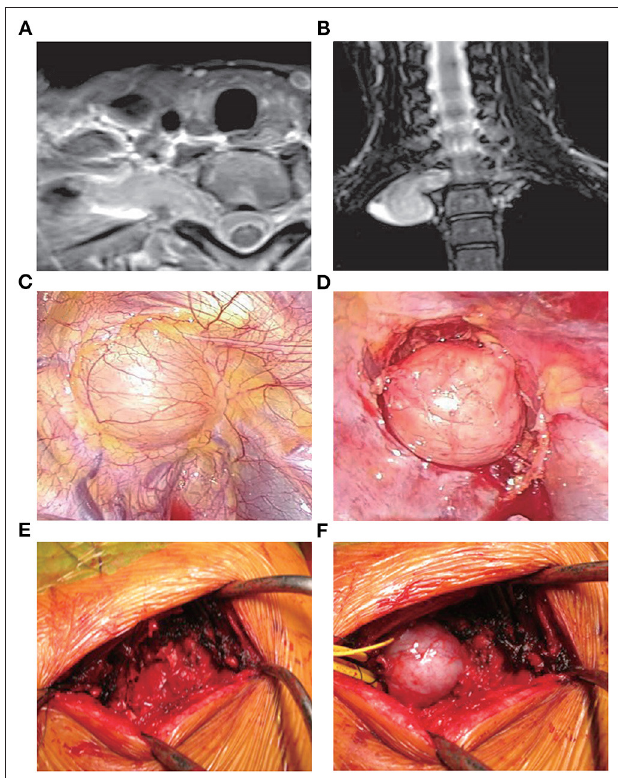
FIGURE 2 | Treatment with VATS (25). A 41-year-old female presented with an abnormal shadow on the apical portion of the right lung and motor weakness of the intrinsic muscle in her right hand. Examination revealed the presence of a dumbbell tumor of the right T1 nerve root, extending to the foramen and paravertebral region. Due to her symptomatic presentation, the patient underwent VATS along with posterior spinal surgery. Initially, anterior release using VATS in the left lateral position was performed. During posterior spinal surgery following VATS, a response to intraoperative nerve stimulation on the T1 nerve root distal to the tumor was confirmed. Therefore, enucleation of the tumor was performed using an operating microscope to preserve the function of the intrinsic muscle. (A,B) Magnetic resonance imaging images showing the presence of a dumbbell tumor at the right T1 nerve root, extending to the foramen and paravertebral region. (C) The tumor during VATS. (D) The tumor after the anterior release of the ambient organs. (E) Partial costotransversectomy was performed following VATS. (F) The preceding VATS ensured tumor mobility in the prone position. The tumor was moved to the surface through gentle handling. VATS, video-assisted thoracoscopic